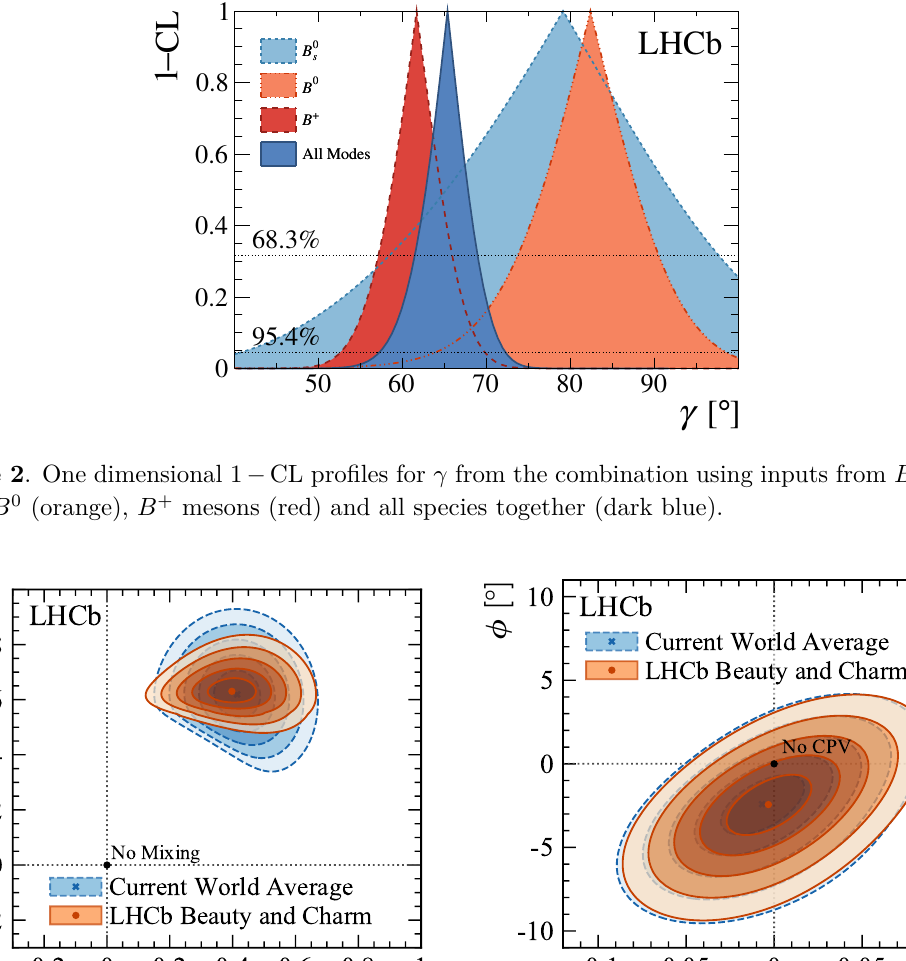
Figure 3 . Two-dimensional profile likelihood contours for (left) the charm mixing parameters x and y , and (right) the φ and | q/p | parameters. The blue contours show the current charm world average from ref. [11]; the brown contours show the result of this combination. Contours are drawn out from 1 ( 68 . 3% ) to 5 standard